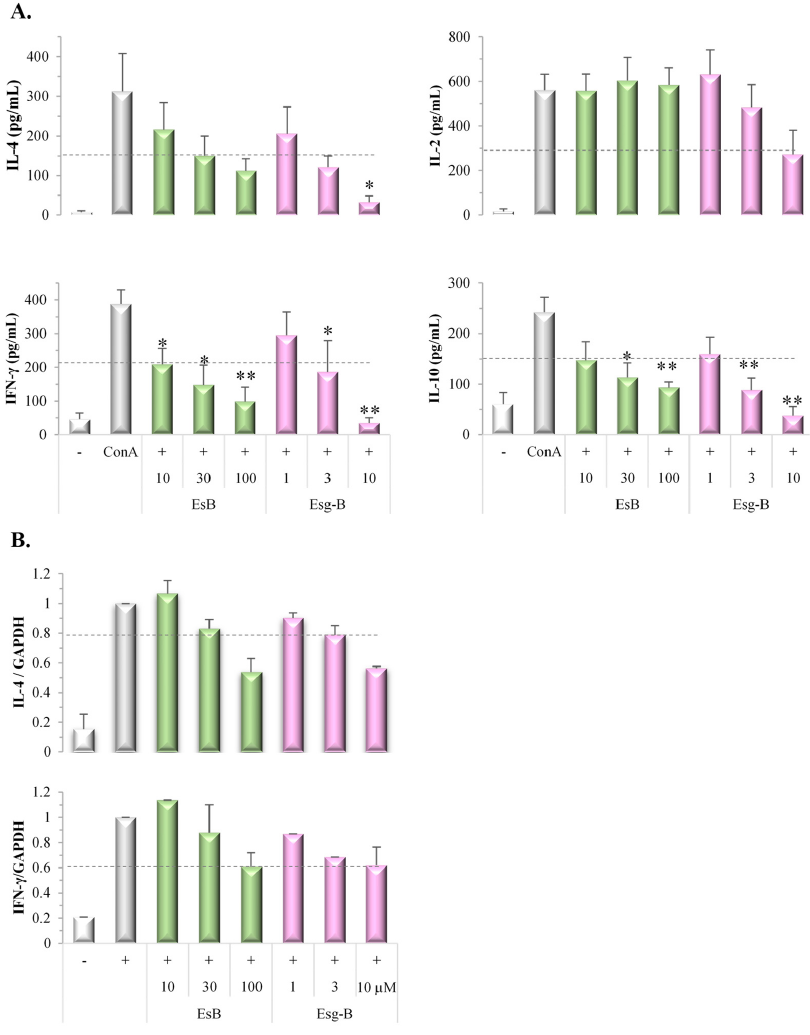
Figure 5. Modulation of ConA blast-induced cytokine production and gene expression by